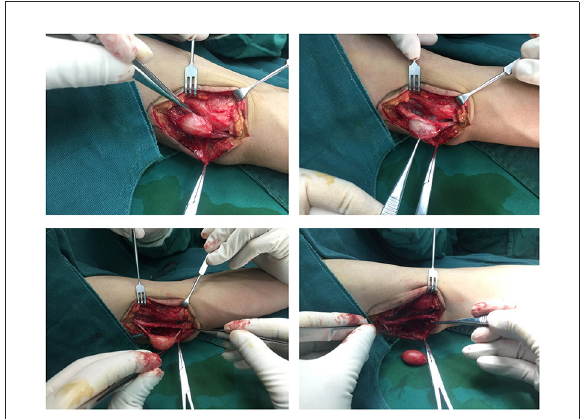
FIGURE8 A nerve bundle was seen passing over the surface of an ulnar nerve-derived mass, which was meticulously dissected to preserve the integrity of this bundle.